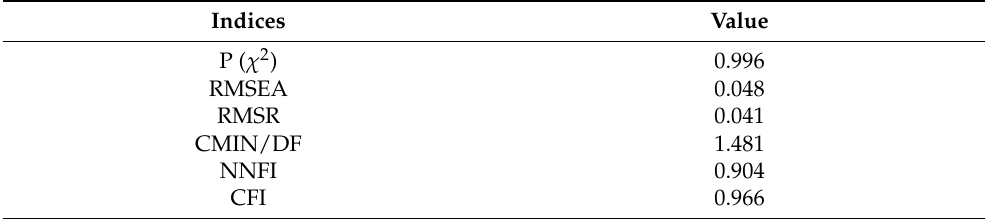
Table 6. Goodness of fit indices.